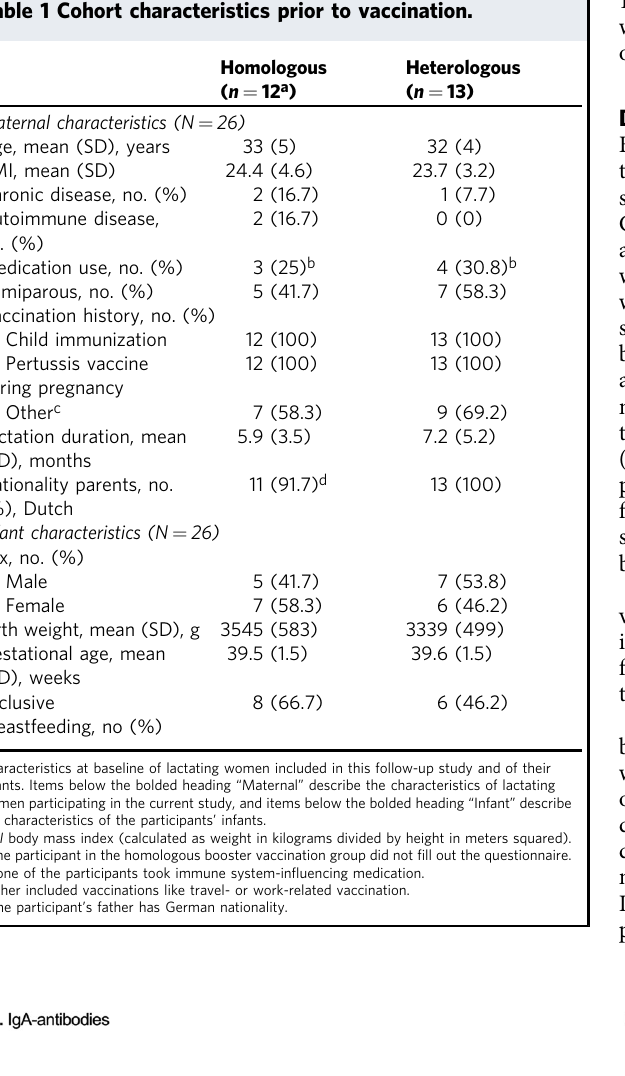
Table 1 Cohort characteristics prior to vaccination.